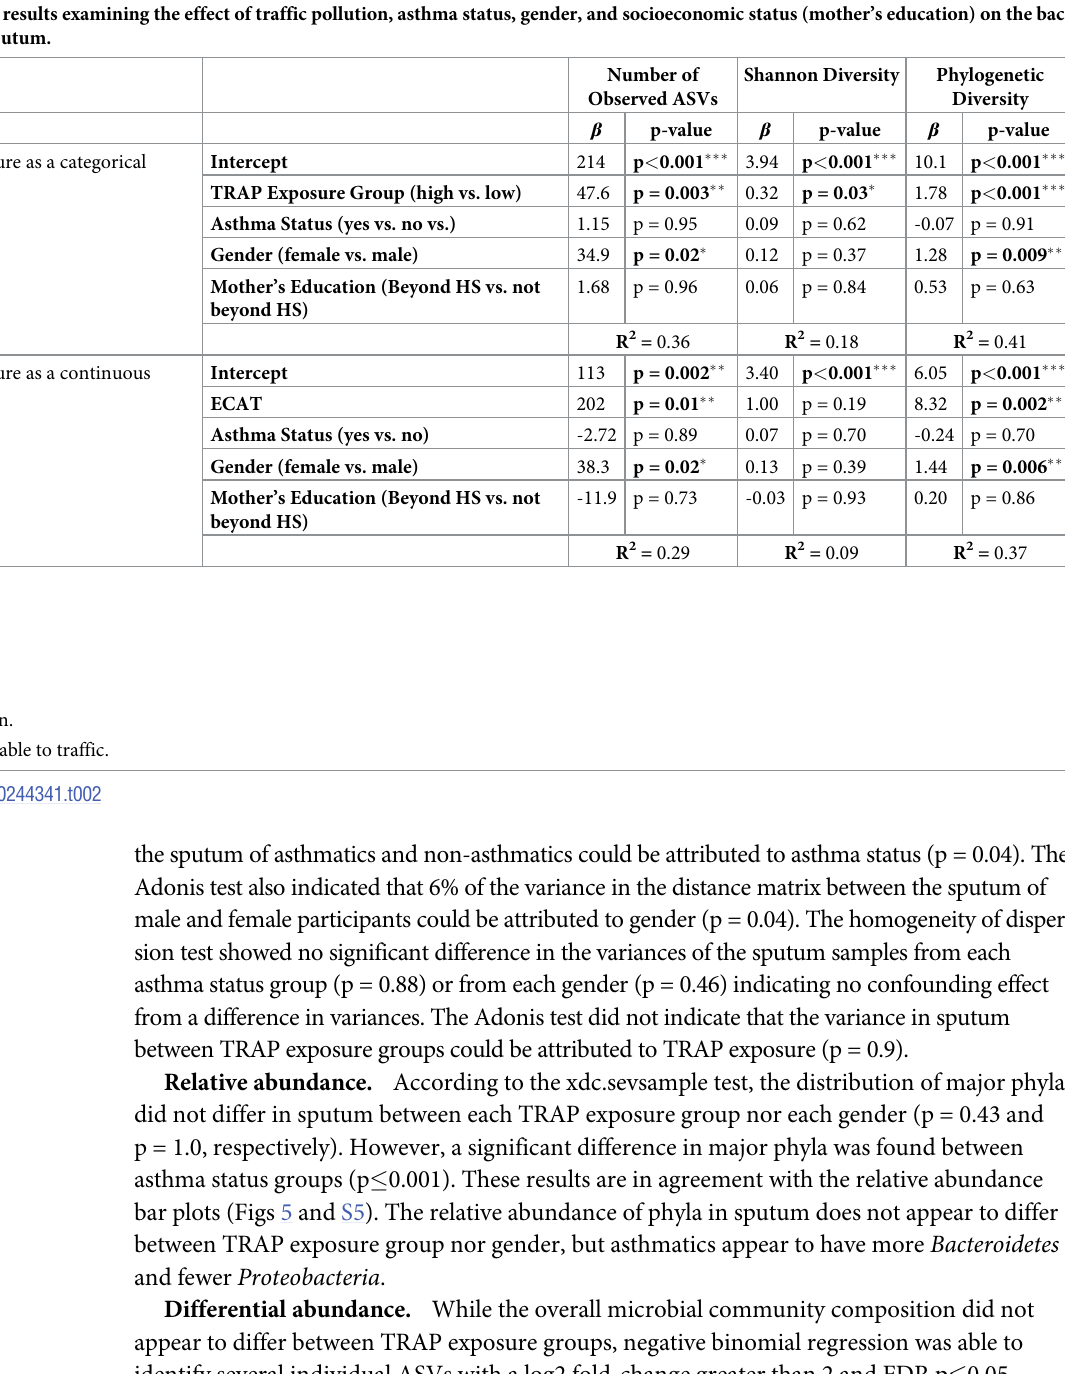
Table 2. Linear regression model results examining the effect of traffic pollution, asthma status, gender, and socioeconomic status (mother’s education) on the bac- terial alpha diversity indices in